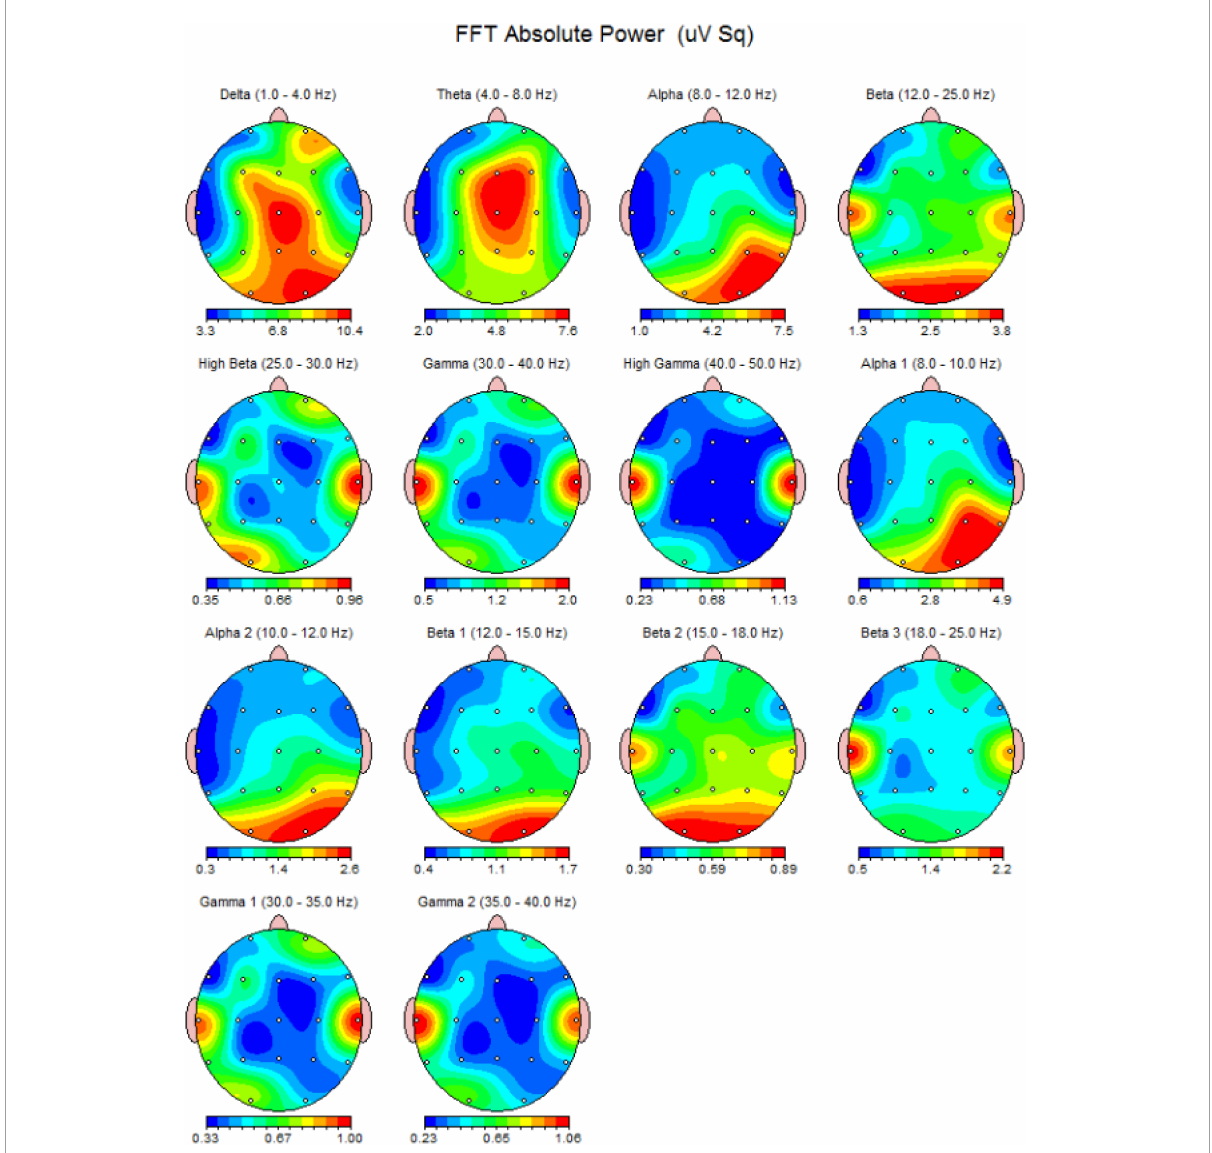
FIGURE2 An EEG power spectrum of a 23-year-old healthy volunteer. It presents a topographic representation of each power-band activity in detail. The data obtained from 19-channel MitsarEEG-202 device. The activations are shown in jet color